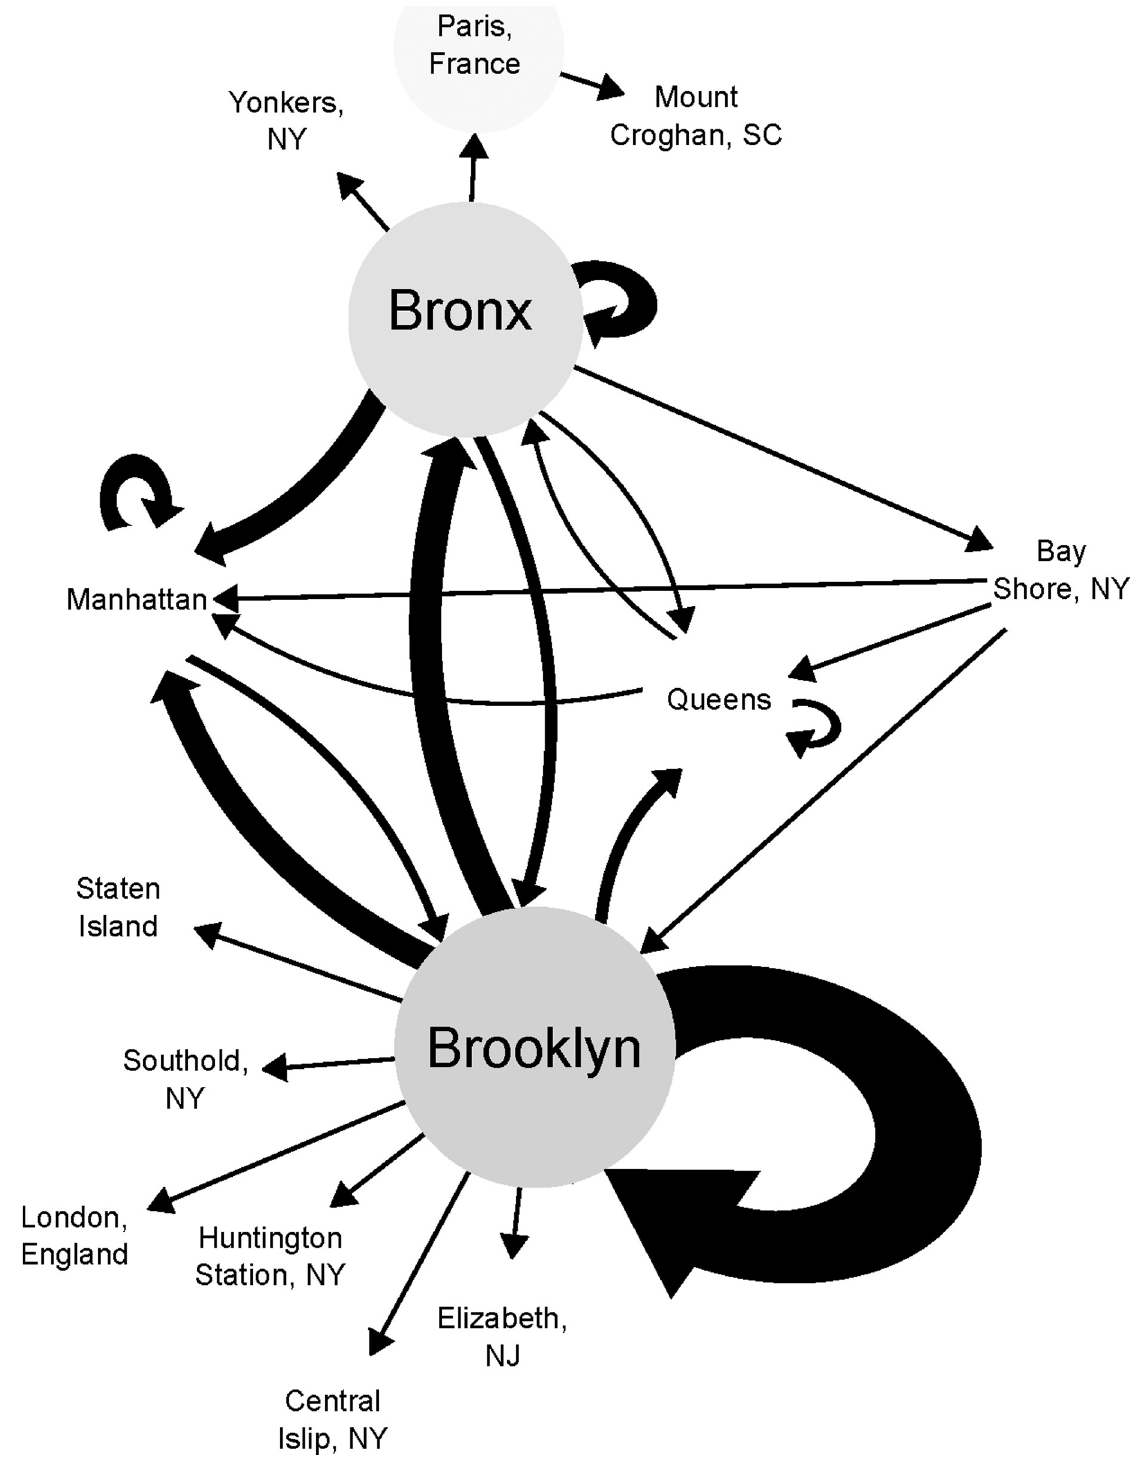
Fig 2. Betweenness and the movement of Nm around NYC boroughs. Locations with higher betweenness values have a darker colored circle. The arrows indicate the direction of movement with the size of the arrowheads and thickness of arrow scaling with the amount of movement between those locations, with a larger size indicating greater